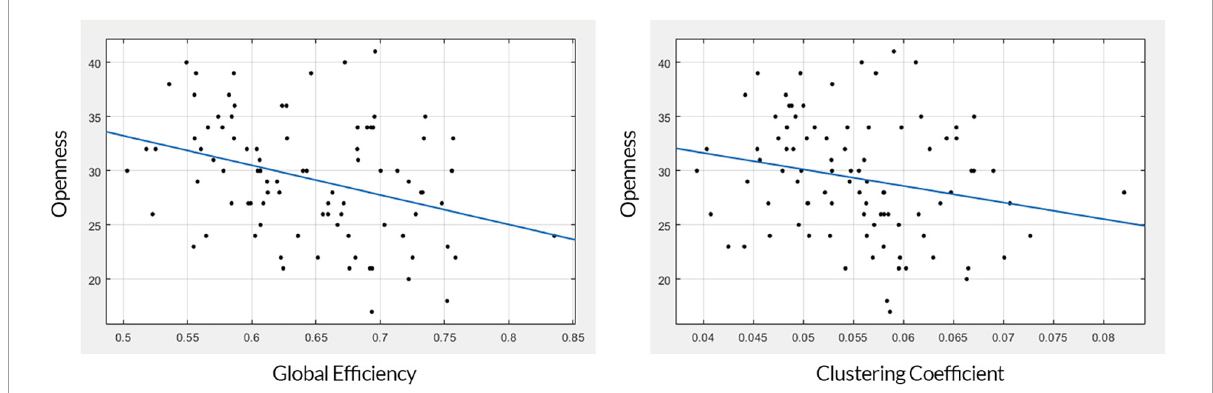
FIGURE2 Linear correlation plots. The plot on the left shows the association between global efficiency (x-axis) and openness to experience (y-axis). The plot on the right shows the association between the clustering coefficient (x-axis) and openness to experience